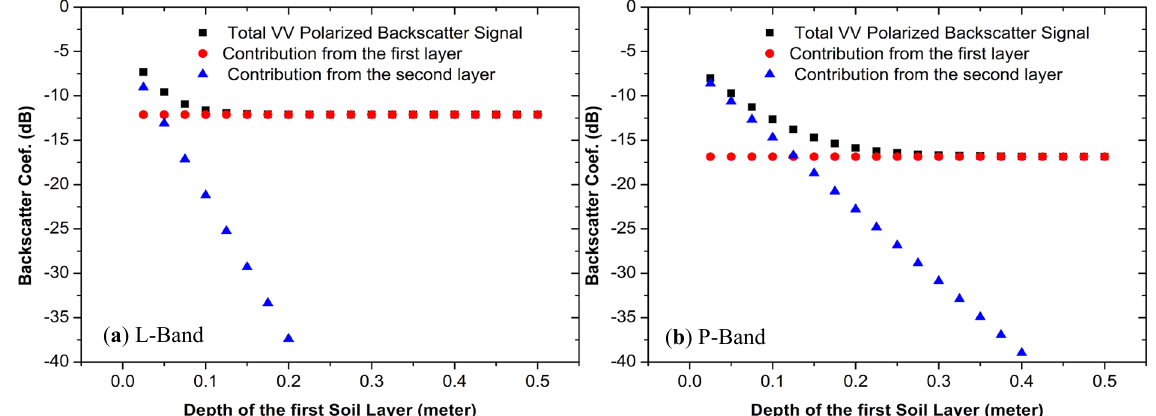
Figure 5. Total radar backscatter and associated dB contributions from different soil layers with varying first-layer soil depths for VV polarization at ( a ) L-band and ( b ) P-band simulated by the FTSS model (wet-dry case with VWC 35% for the first layer and 5% for the second layer,